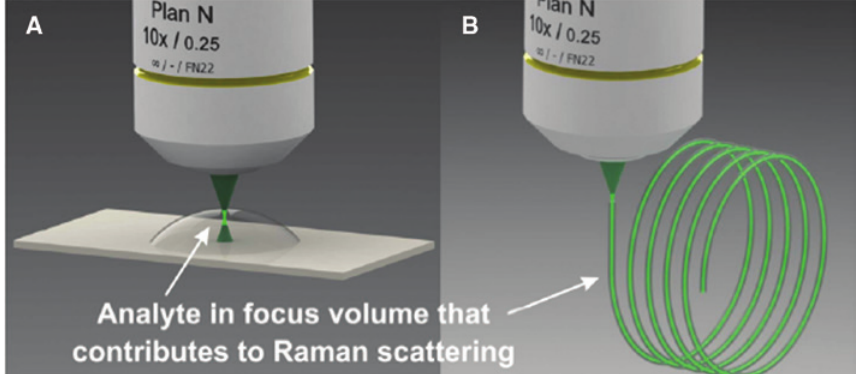
Figure 7: Comparison between the limited collection volume in conventional Raman spectroscopy (A) and the extended interaction volume in FERS